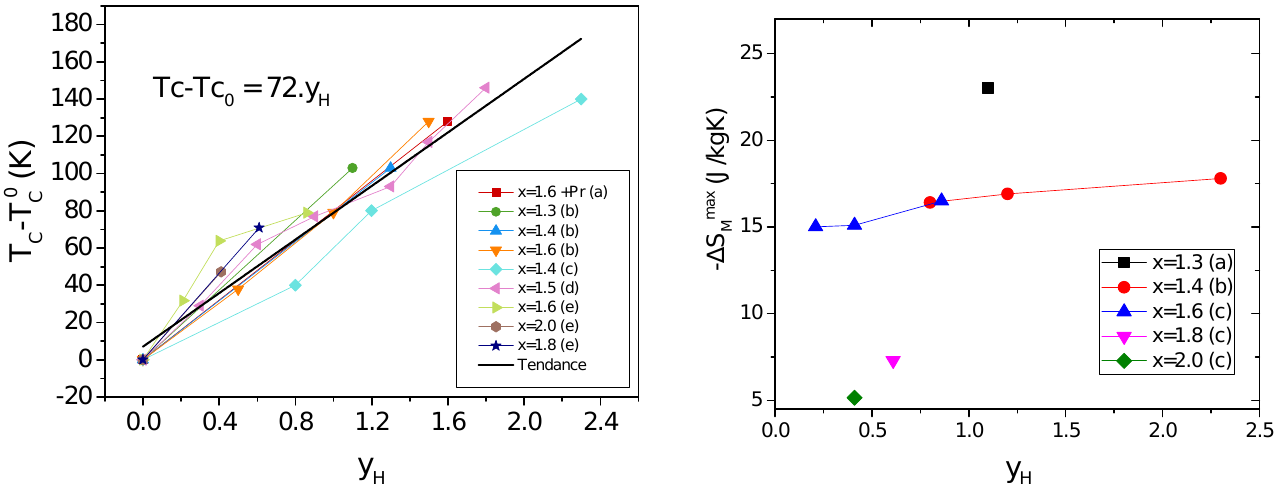
Figure 12. ( Left ) Evolution of the Curie temperature for materials in which hydrogen has been inserted vs. the insertion rate y H (a) [72], (b) [35], (c) [71], (d) [68], and (e) [70]. ( Right ) ∆ S max (b) [71], and (c)